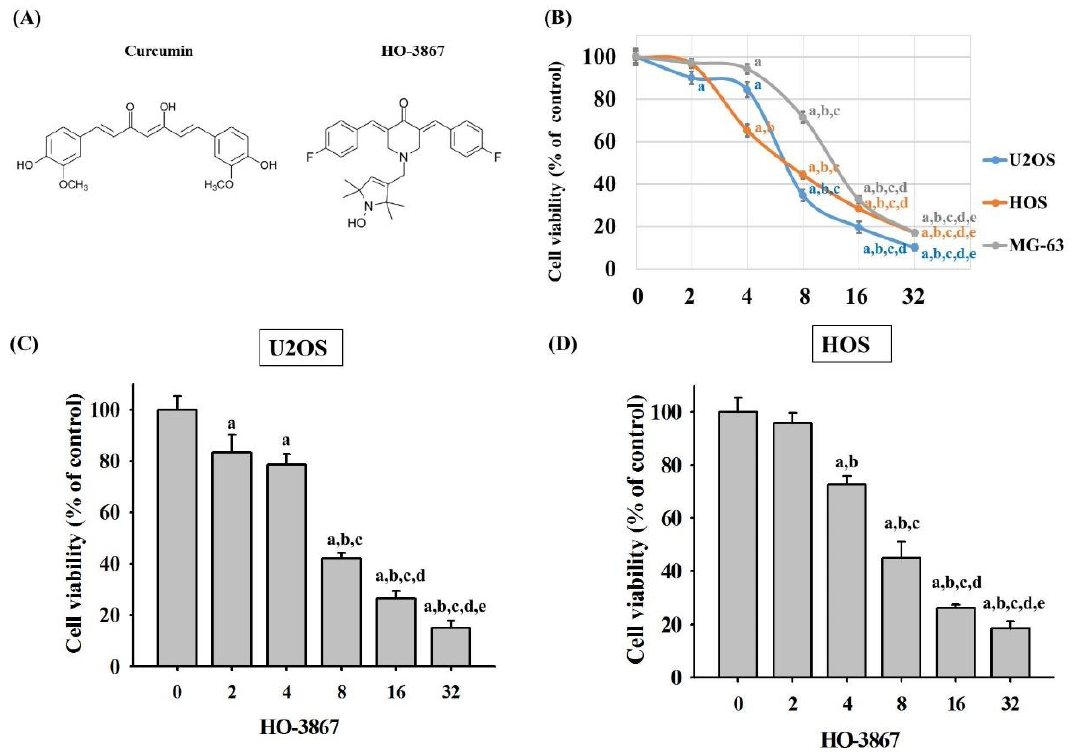
Figure 1. Analysis of cell viability in free and HO-3867-treated U2OS, HOS and MG-63 cells. ( A ) The chemical structures of curcumin and curcumin analog HO-3867 were drawn; ( B ) MTT assay